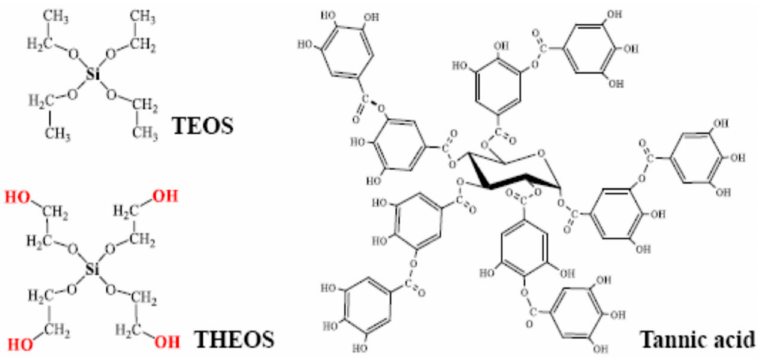
Figure 1. Structural formulas of tetraethoxysilane (TEOS), tetrakis(2-hydroxyethyl)orthosilicate (THEOS) and tannic acid